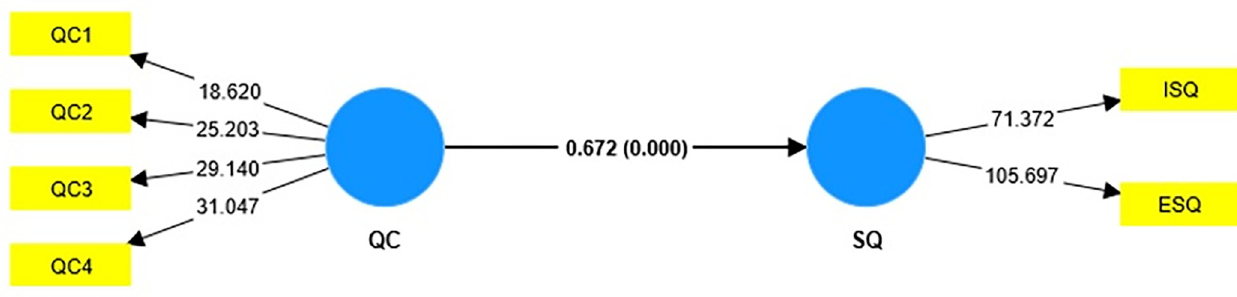
Fig 2. Structural model